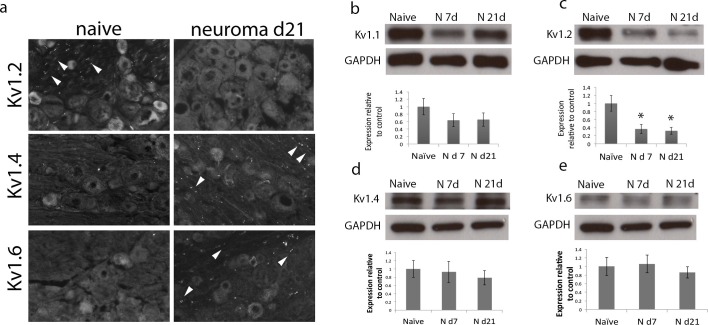
Expression of Kv1 channels in the DRG in the naïve state, 7 and 21 days after axotomy (neuroma).(a) Representative sections of naive and neuroma day 21 DRG immunostained with Kv1.2, Kv1.4, and Kv1.6. Note that Kv1.2 expression in DRG cells and axonal juxtaparanodes (arrow heads) is reduced after injury, while Kv1.4 and Kv1.6 expression remains unchanged in DRG cells, and it is present in axonal juxtaparanodes (arrow heads) after injury. In each panel (b–e), a representative blot is shown for each time point with GAPDH as a loading control. Quantification of 6 animals per condition is shown below (b,d,e) Expression of Kv1.1, Kv1.4 and Kv1.6 within the DRG does not significantly change after axotomy. (c) Kv1.2 expression is significantly decreased after axotomy. (*p<0.05, one Way ANOVA, n = 6 per group).DOI:
http://dx.doi.org/10.7554/eLife.12661.01310.7554/eLife.12661.014Figure 6—source data 1.Source data for Figure 6.